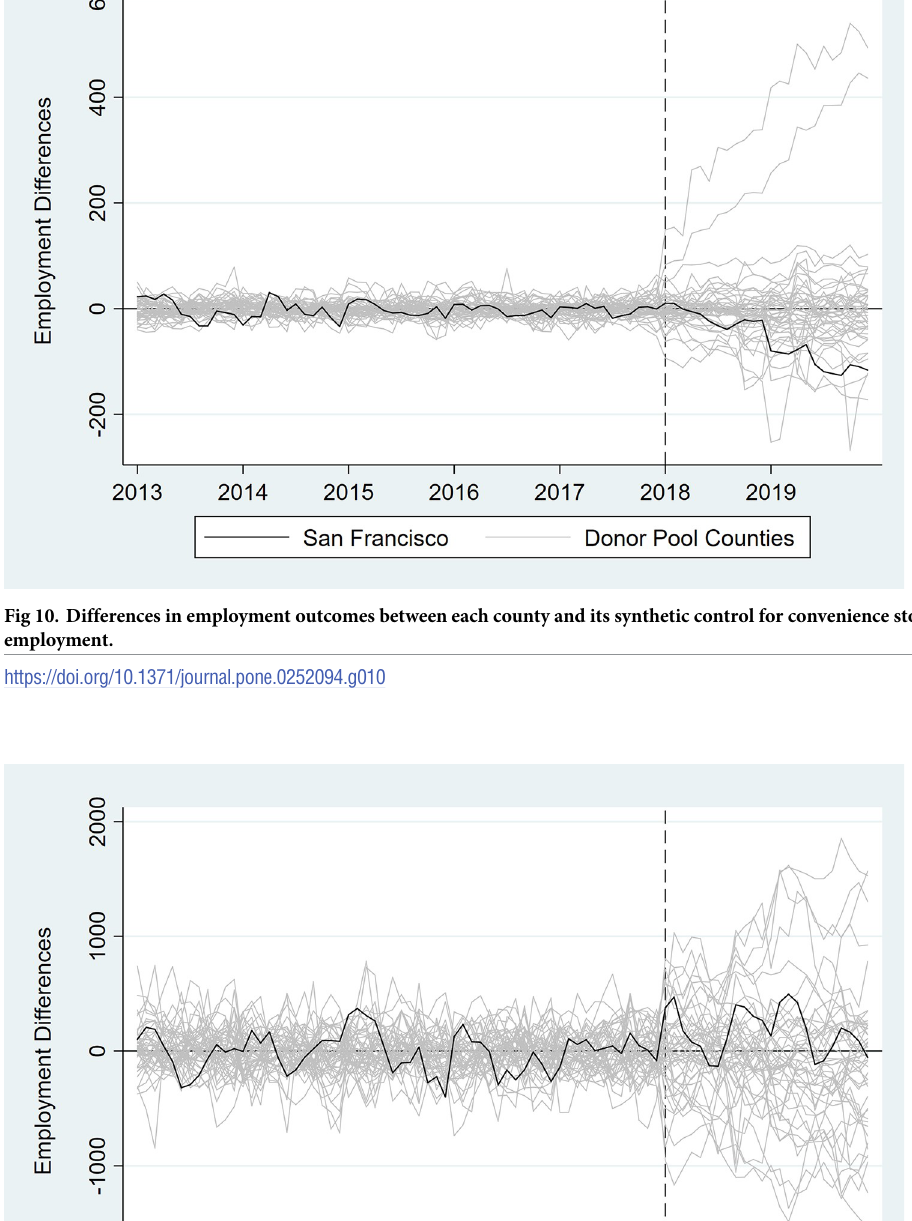
PLOS ONE | https://doi.org/10.1371/journal.pone.0252094 June 2,